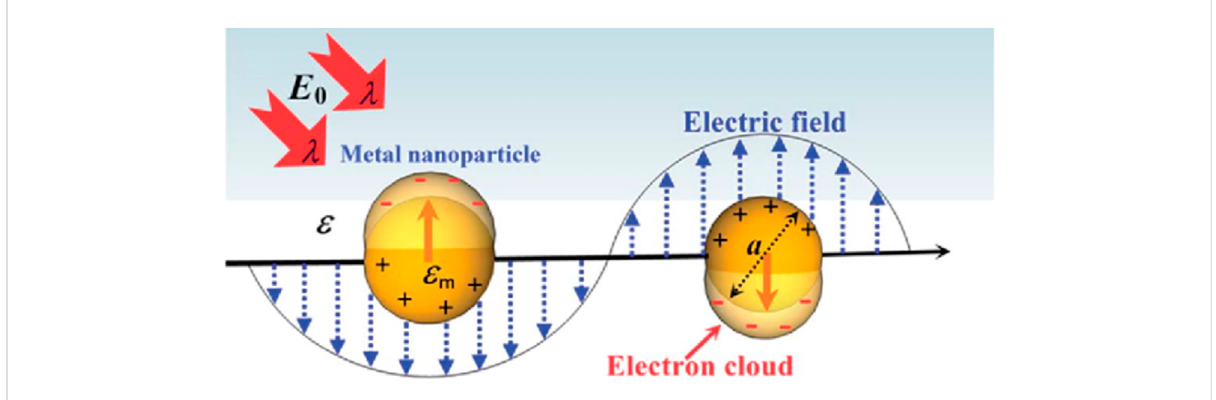
FIGURE 6 Systematic demonstration of light responses of plasmonic materials (Chou and Chen, 2014); Reproduced with permission. Copyright 2014 Royal Society of